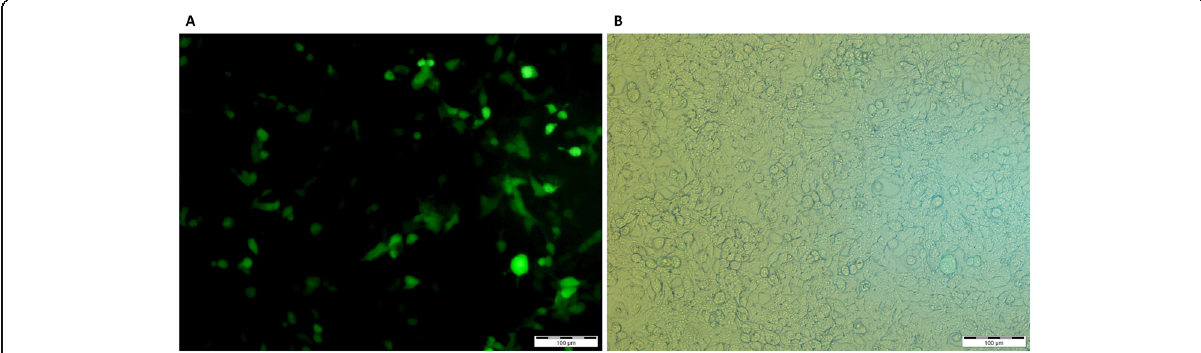
Fig. 3 Efficient transfection of pX458 plasmids into pX458 cells. a represents the GFP + cells visualized using fluorescent microscopy, and b shows the same cells with normal visible light (scale bars 100 μ